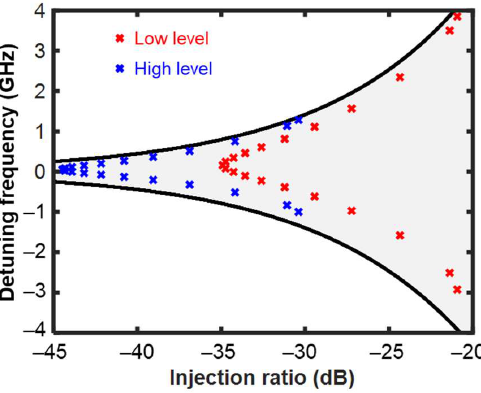
Figure 5. Calculated injection-locking parameters for 21 SLs for non-return-to-zero on–off keying modulation. Red and blue crosses correspond to the conditions for low-level and high-level signals, respectively.